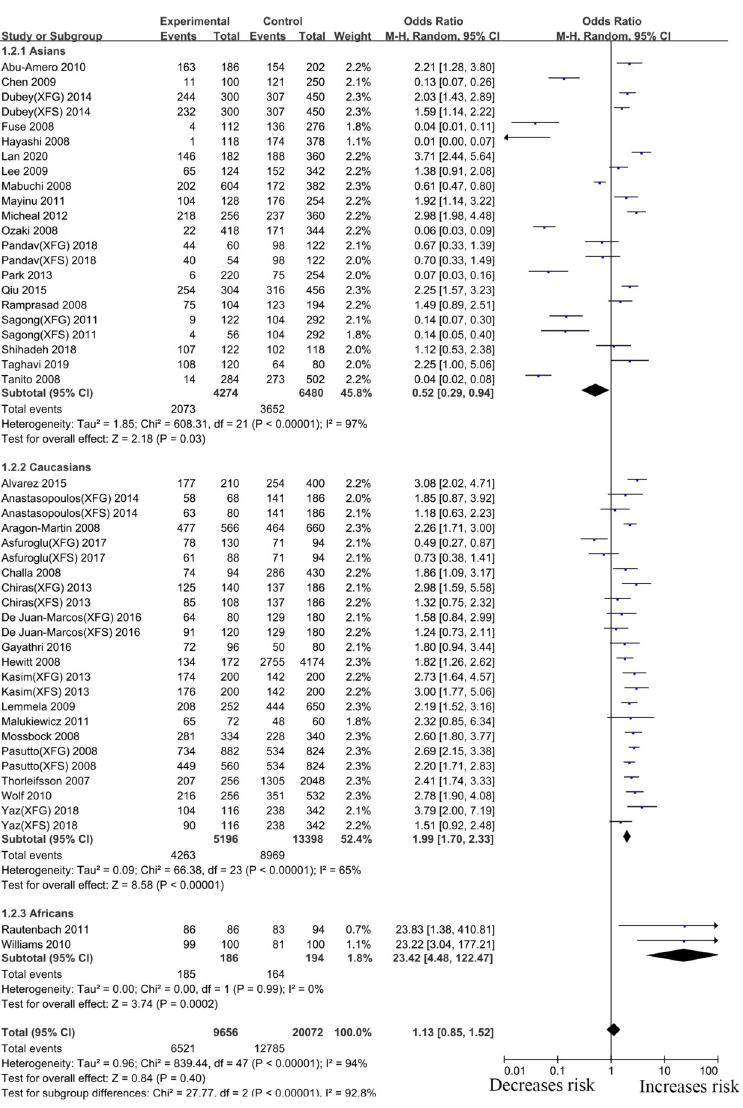
Fig 3. Meta-analysis for the association between exfoliation syndrome/exfoliation glaucoma risks and LOXL1 gene polymorphism rs1048661 (G vs. T): Subgroup analysis by ethnicity (squares depict individual studies and diamonds depict summary effect size estimates (Odds Ratio,